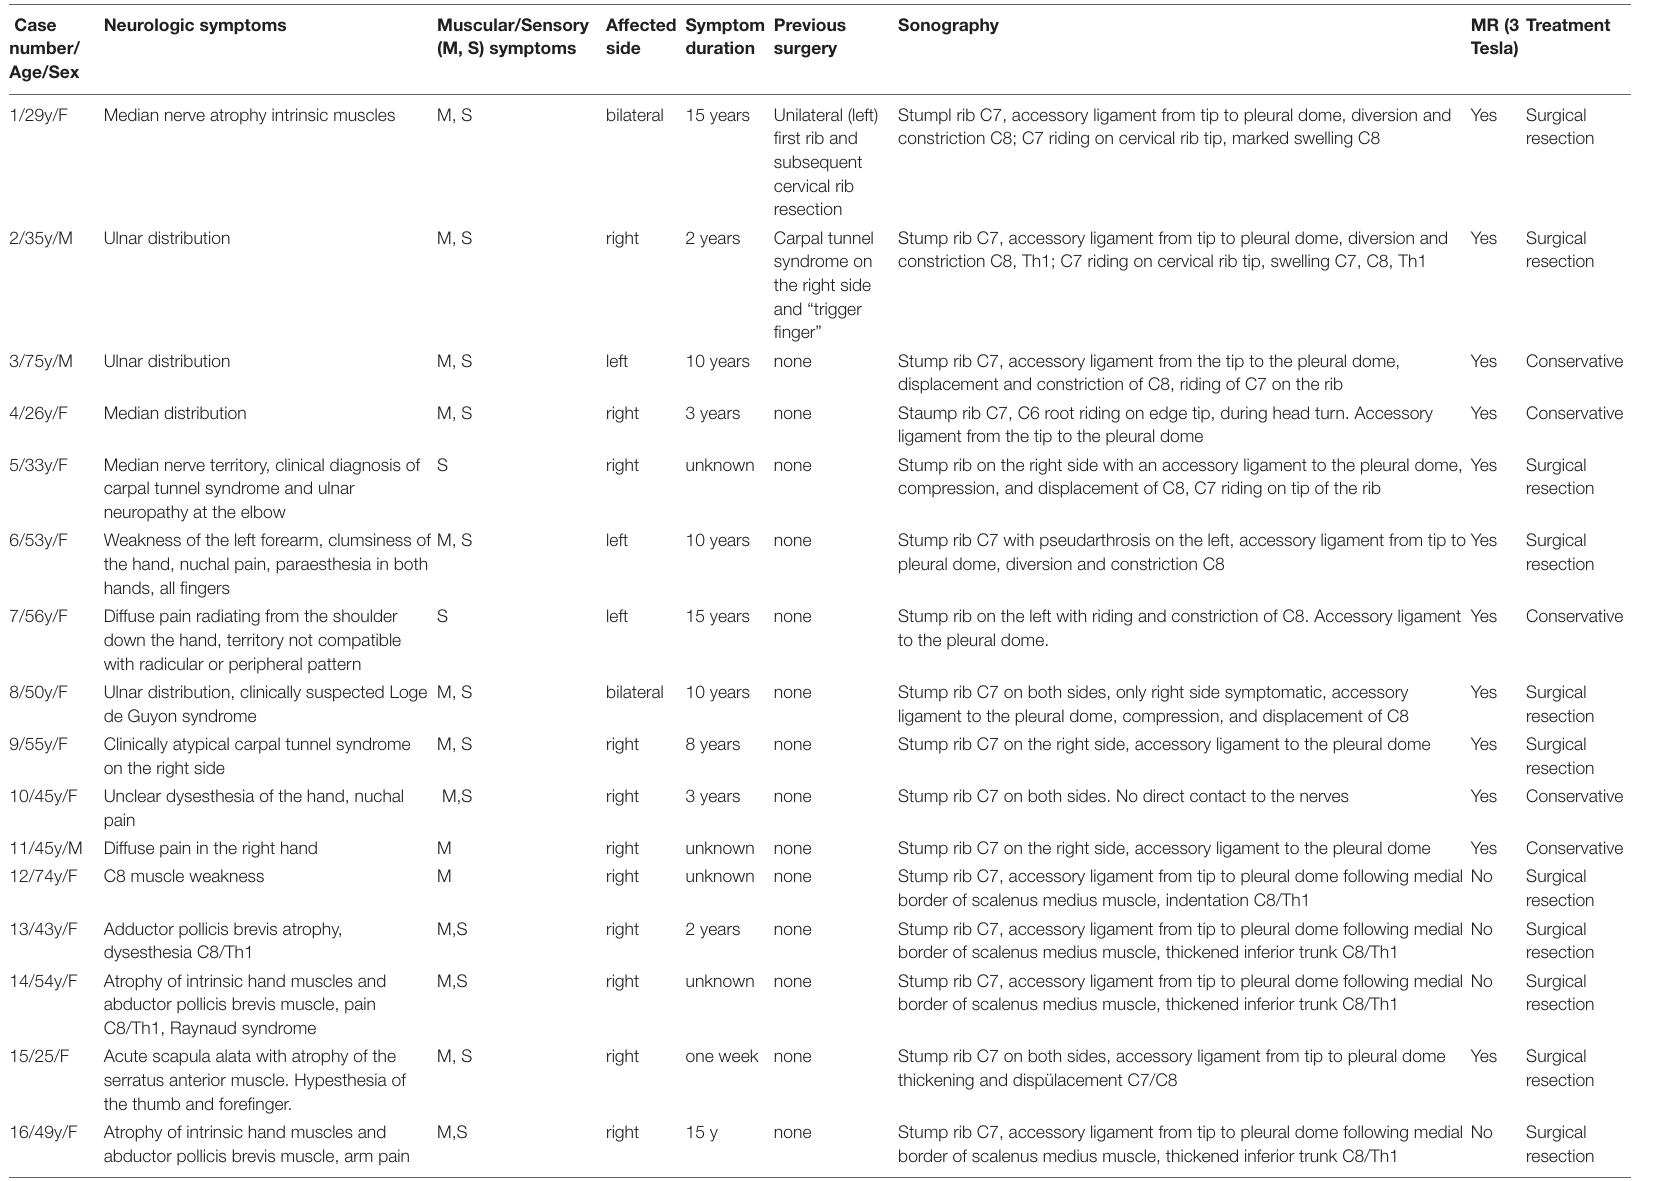
TABLE 1 | Detailed chart review of all patients included in this study. In the top column the symptoms, results, therapies and examinations considered in this study are listed. Case number/